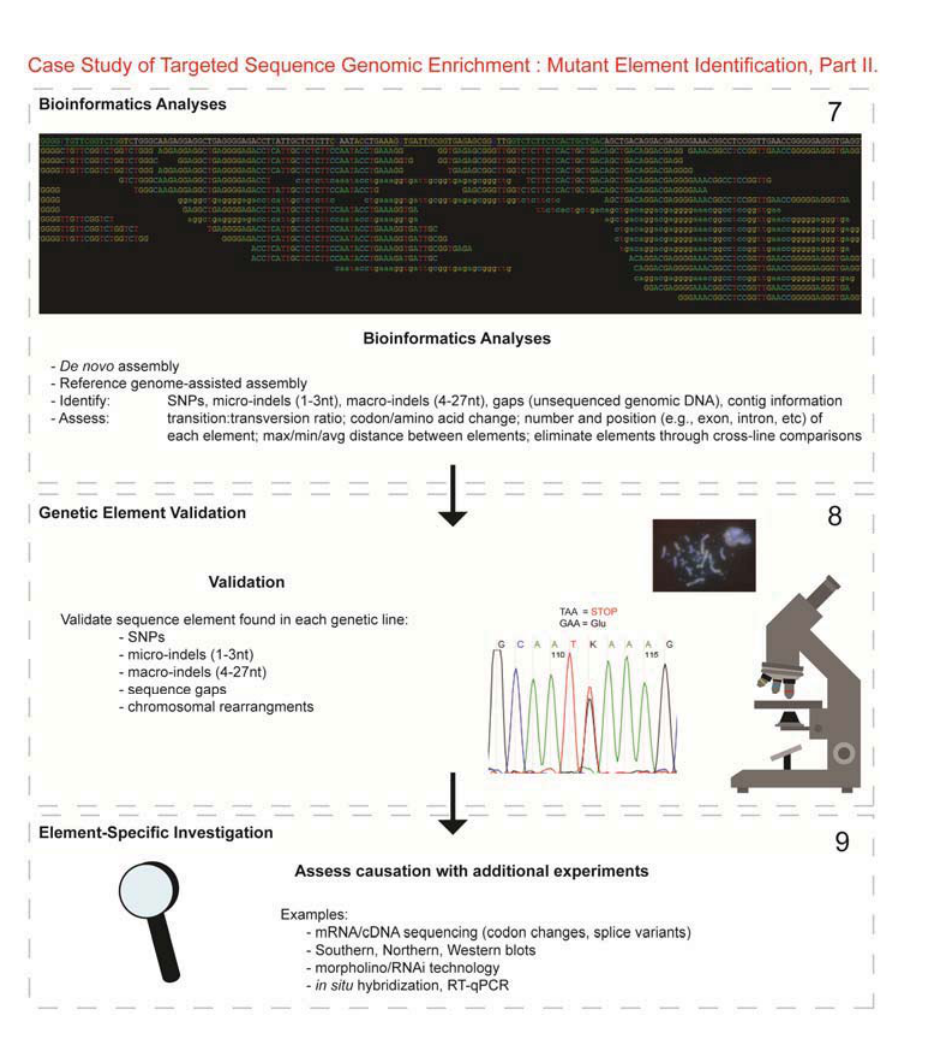
Figure 2. Targeted Sequence Genomic Enrichment Methodology, Part II. Analysis of the targeted genomic capture enrichment and next-generation sequencing data allowed for the identification of variants and chromosomal rearrangements which were further validated using new mutant samples in order to identify the causative element for each of the developmental mutations. Approximate timeline from obtaining the raw SOLiD™ (colorspace) sequence reads to validating the sequence variants identified (steps 7–8) was 6